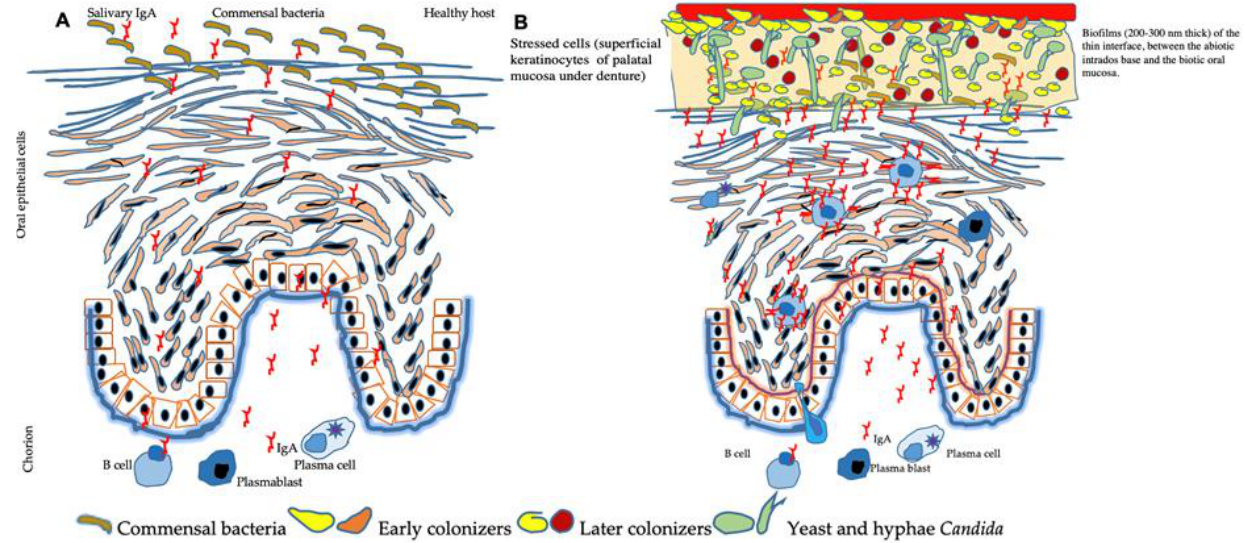
Figure 5. Under a removable prosthesis, the palatal mucosa can react by the appearance of signals, such as molecular models associated with damage (DAMP) and to damage cells or molecular models associated with pathogens (PAMPs). These surface signals alert different cells of the host deep down, which causes the activation of neutrophils. On the left ( A ), in the absence of C. albicans , salivary and tissue IgA regulate local immunity. These igAs participate in the homeostasis of the microbiota by binding to native bacteria. On the right ( B ), the presence of commensal C. albicans promotes the migration of mature B cells, plasmablasts, and plasma cells through the mucosa. IgA by binding to C. albicans decreases adhesion and slows down fungal colonization. Thus, the IgA will decrease the intensity of the pro-inflammatory response.